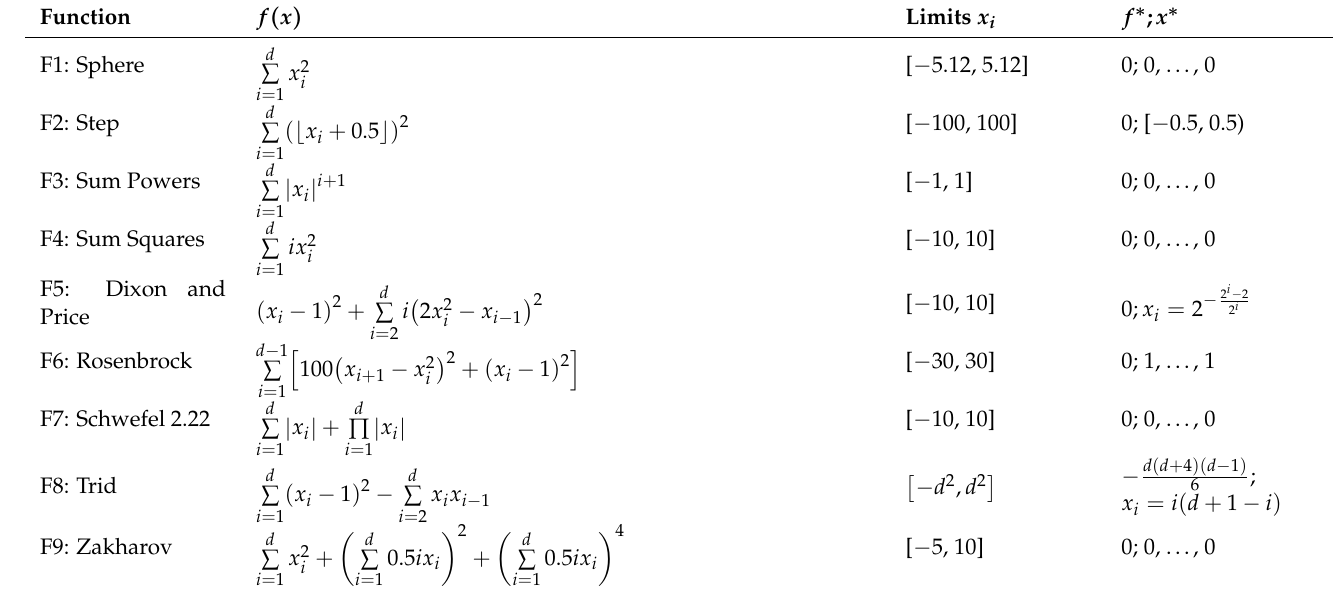
Table 3. D > 2 objective functions. The optimum value is denoted as f ∗ and x ∗ is the candidate